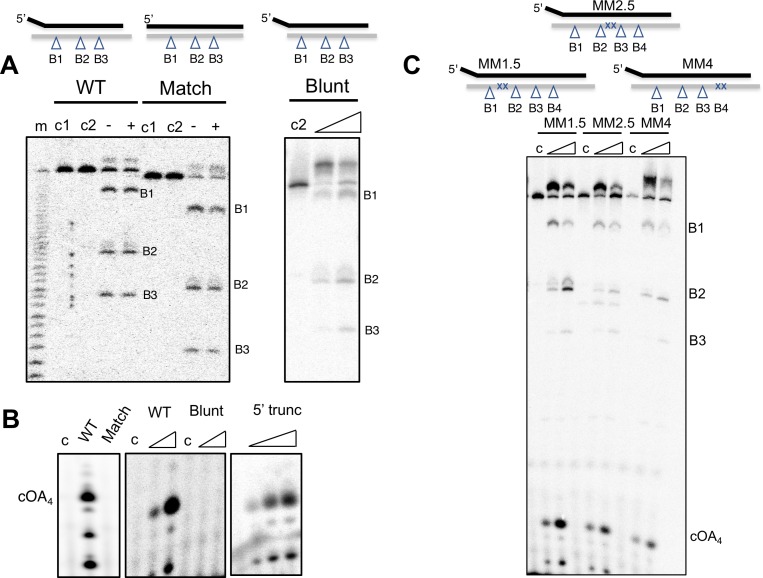
Backbone cleavage and cOA production for target RNAs with altered 5’ and 3’ ends.(A) Backbone cleavage for Target RNA wild-type, Match (with eight nt match to 5’ handle of crRNA) and 3’-blunt (with no 3’ extension). All three targets are cleaved by the Csm complex. Control c1 and c2 represent incubation of target RNA without Csm for 30 min at 0 or 70°C, respectively. Lanes – and + represent assays in the presence or absence of 1 mM ATP, respectively. For the 3’-blunt target, time points of 5 and 30 min are shown. (B) cOA production is seen for the WT but not the Match or 3’-blunt targets. A control target (5’ -blunt) lacking the 5 nt 5’ overhang present in the WT target behaves like the WT target. This serves as a control for the Match target, which also lacks these 5 nt. Lane c is run in the absence of Csm protein. The time points are 5 and 30 min for WT and 3’-blunt, and 5, 10, 30 min for the 5’-blunt substrate. All oligonucleotide sequences are shown in Table 1. (C) Target RNAs carrying mismatches at sites M1.5, M2.5 and M4 all support backbone cleavage and cOA production. Details as for Figure 5.